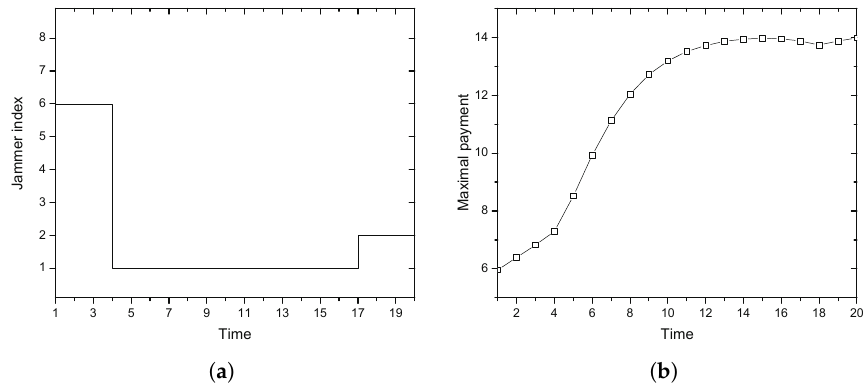
Figure 7. Multiple-jammer effects: ( a ) selected jammer by the greedy policy; ( b ) utility achieved by Alice with multiple jammers.